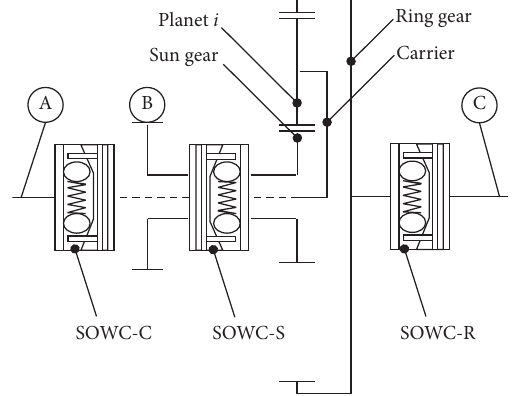
Figure 1: Configurations of the transmission